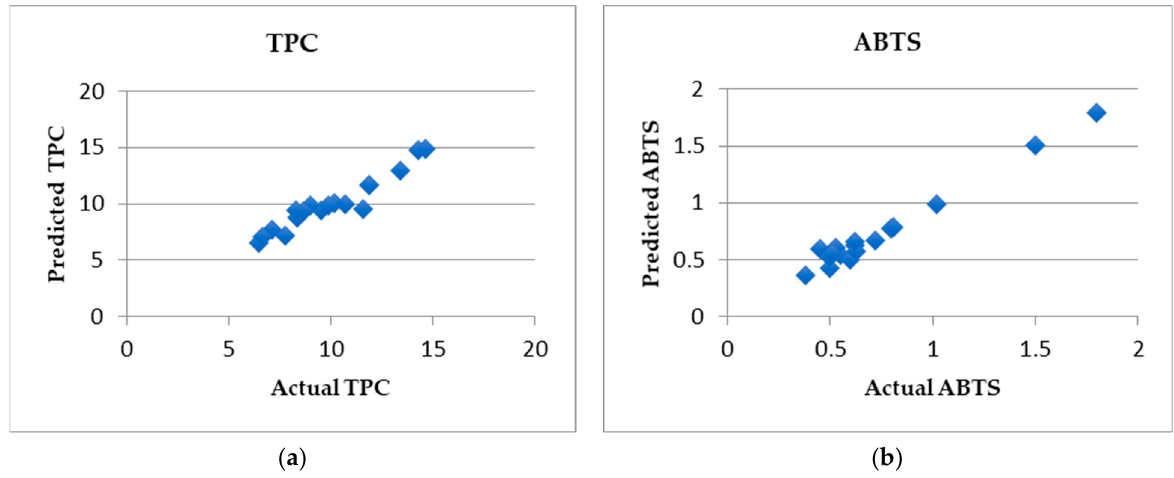
Figure 1. Predicted (based on linear regression) vs. actual values of TPC ( a ) and ABTS ( b ) activity of the samples.